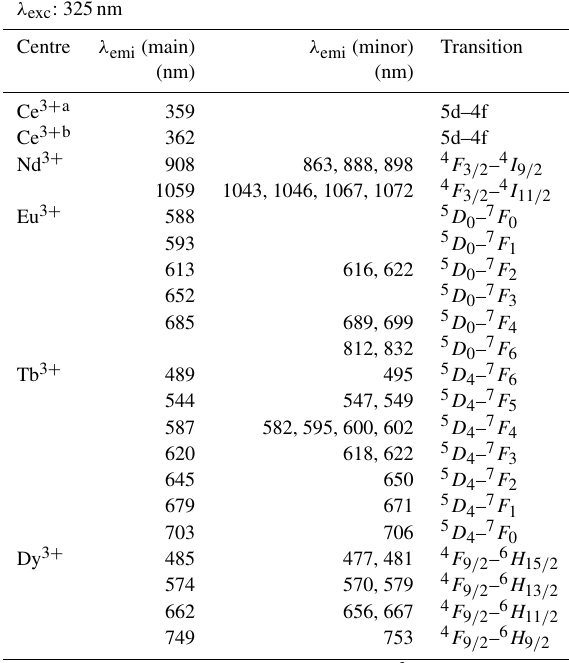
Table 2. Overview of detected emission lines and corresponding transitions for the REE phosphates NdPO 4 , EuPO 4 , TbPO 4 , and DyPO 4 that were successfully excited at 325nm and cerium emis- sion measured in YPO 4 and LuPO 4 ( λ exc : excitation wavelength; λ emi : emission wavelength; main: most intense emission line; mi- nor: additionally detected, less intense emission lines of the same emission band). λ exc : 325nm